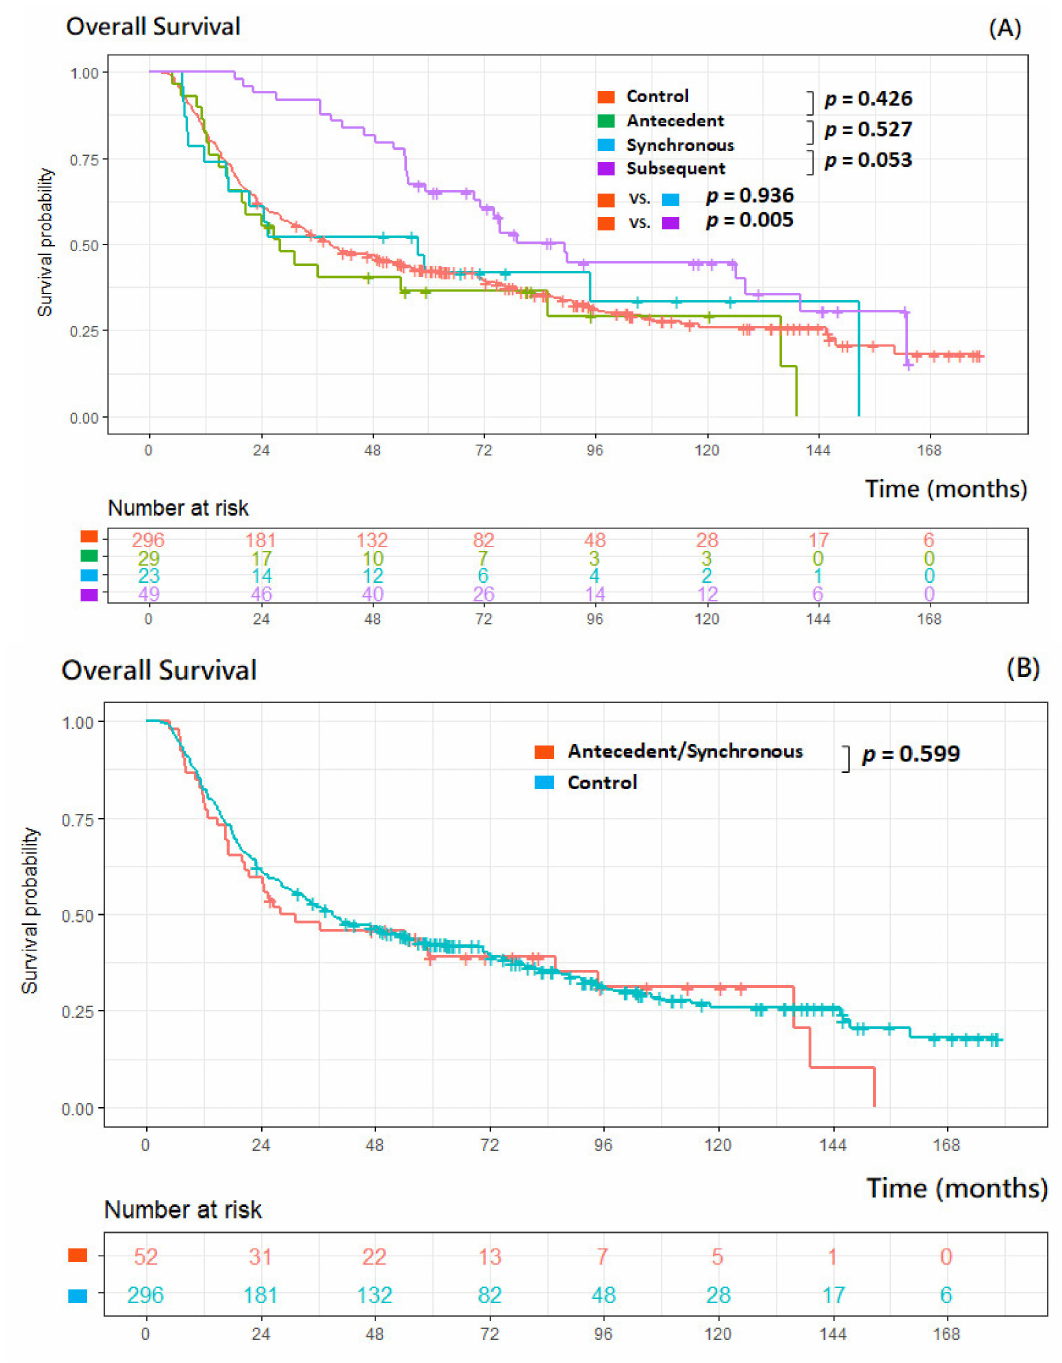
Figure 2. Kaplan–Meier curves according to multiple primary cancer status ( A ), an- tecedent/synchronous and no MPCs (control) group ( B